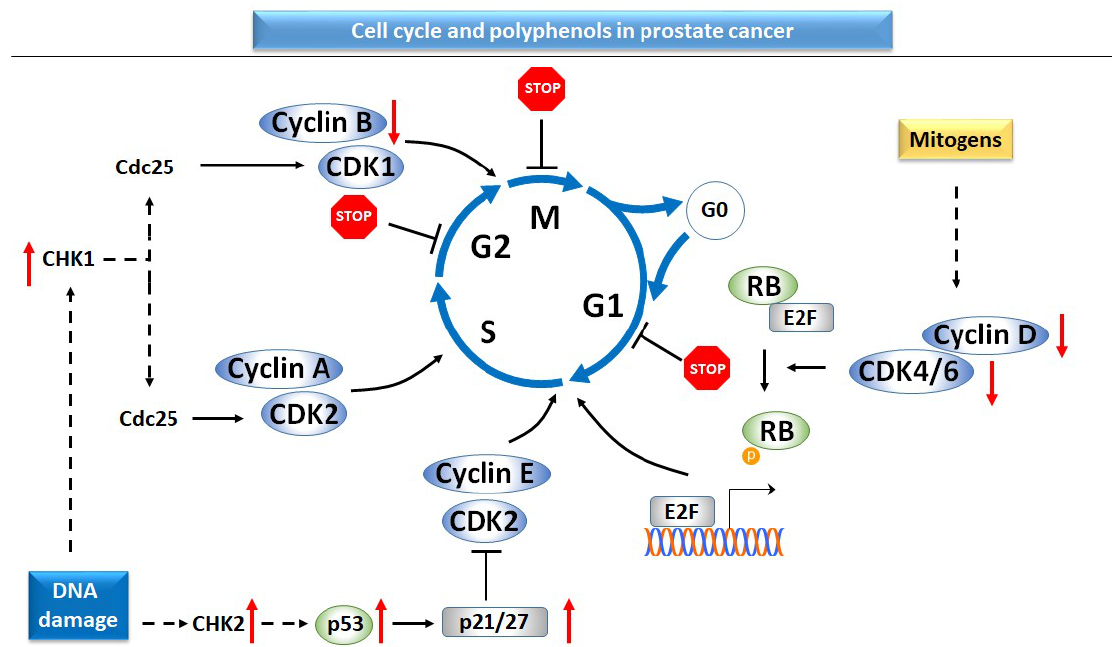
Figure 4. Cell cycle and the inhibitory effect of polyphenols in prostate cancer cells. DNA damage triggers the activation of the tumor suppressor and checkpoint proteins, while mitogen signals induce the progress of the cell through the cell cycle [136]. The following molecules are reported to be downregulated by polyphenols in prostate cancer: cyclin D (apigenin, caffeic acid phenethyl ester, gingerol), cyclin E (caffeic acid phenethyl ester, gingerol, quercetin), CDK2 (quercetin), CDK4 (gingerol), cdc25 (gallic acid). Polyphenols upregulate proteins coded by tumor suppressor genes, such as p53 (apigenin, curcumin, EGCG), p21 (apigenin, EGCG), p27 (apigenin) and checkpoint proteins CHK1, 2 (gallic acid). Moreover, administration of polyphenols induced the cell cycle arrest in a cell‐line‐ and compound‐dependent manner, particularly G2/M arrest (apigenin, gallic acid), G0/G1 arrest (EGCG, quercetin). Legend: cyclin‐dependent kinases (CDK), retinoblastoma protein (RB), transcription factor E2 (E2F), mitosis (M), gap 1 phase (G1), gap 2 phase (G2), DNA synthesis phase (S), CHK, checkpoint proteins; cdc25, cell cycle division protein 25; upregulation (red ↑ ); downregulation (red ↓ ).